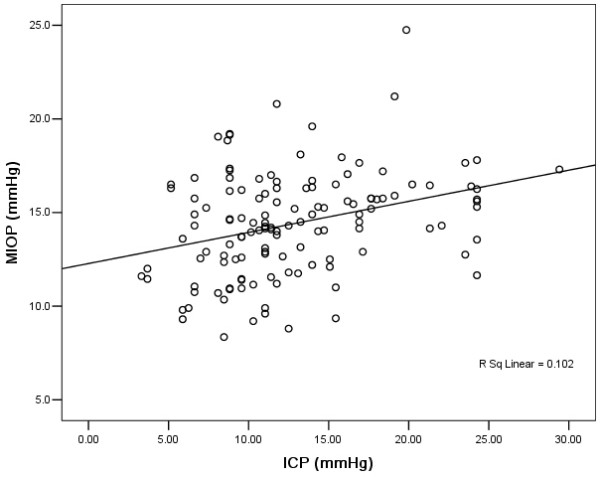
The scatter plot of ICP (mmHg) measurement versus MIOP (mmHg) measurement with a positive correlation (r = 0.320, P < 0.001).